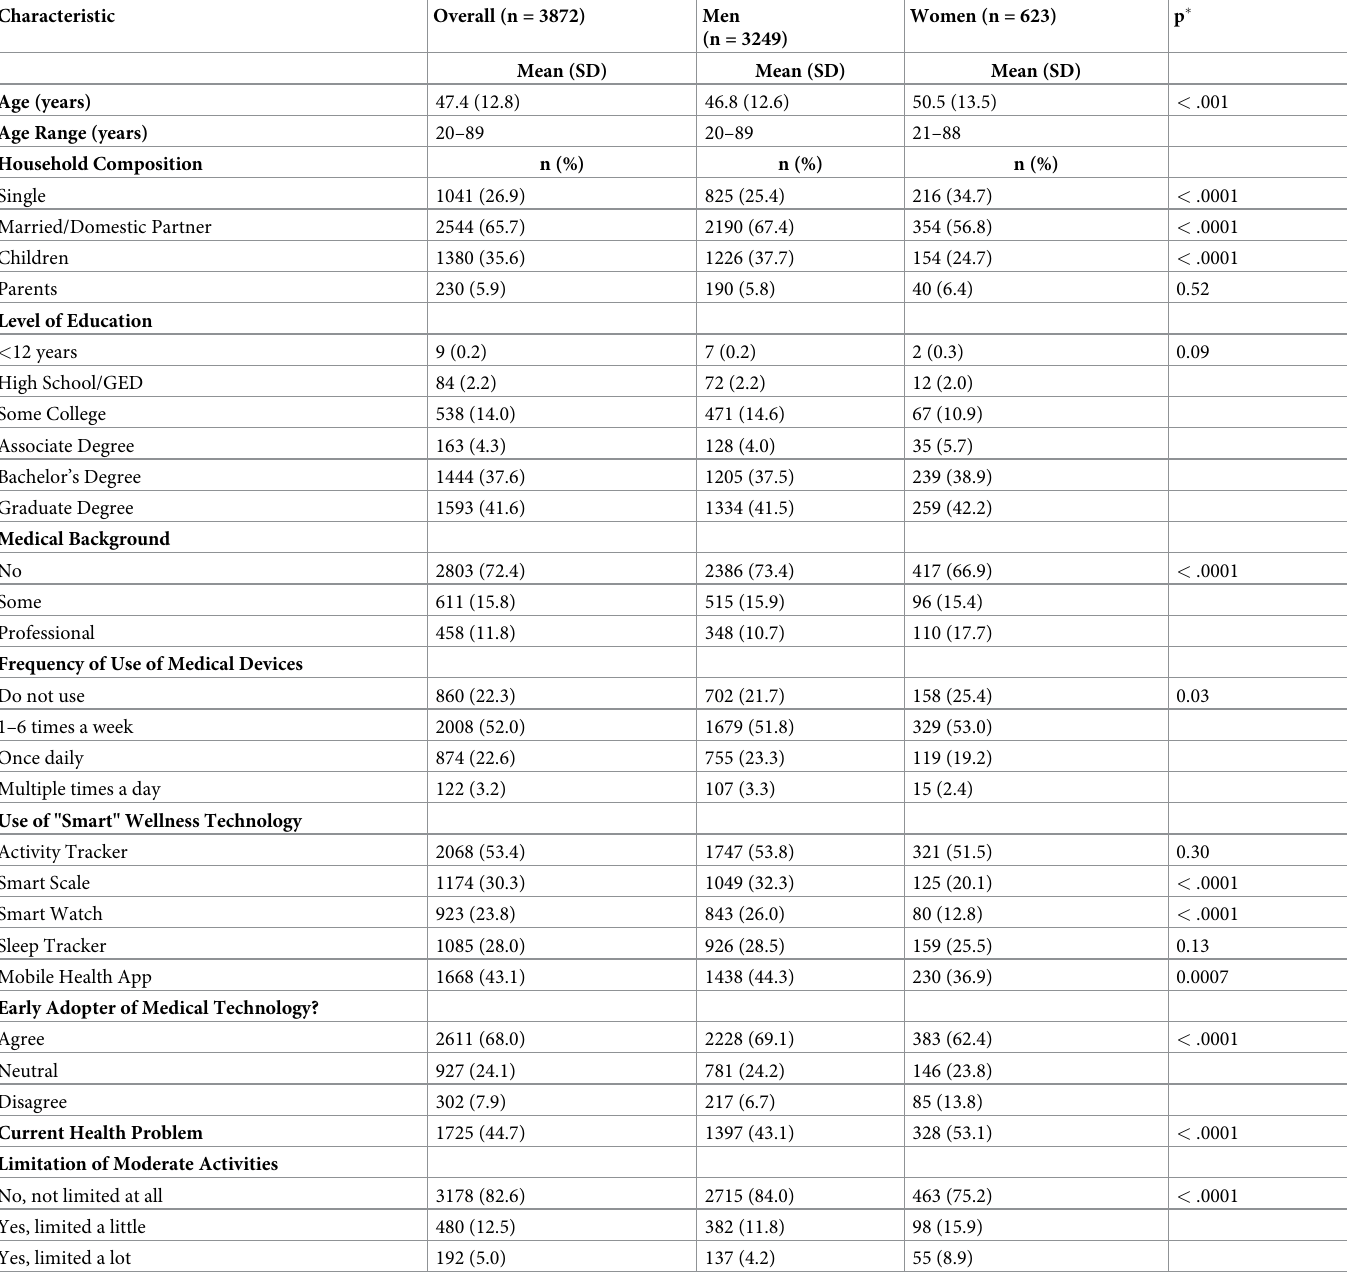
Table 2. Baseline characteristics of all respondents to baseline survey, overall and by